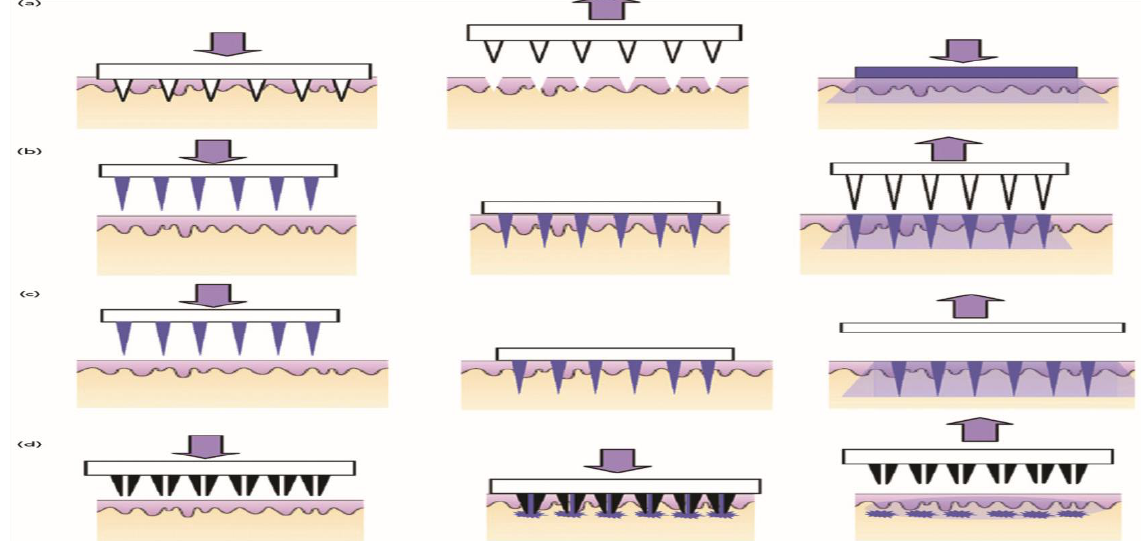
Figure 1 Microneedle Drug Delivery: (a) ‘poke and patch’ (b) ‘coat and poke’ (c) ‘poke and release’ (d) ‘poke and flow ( 31)